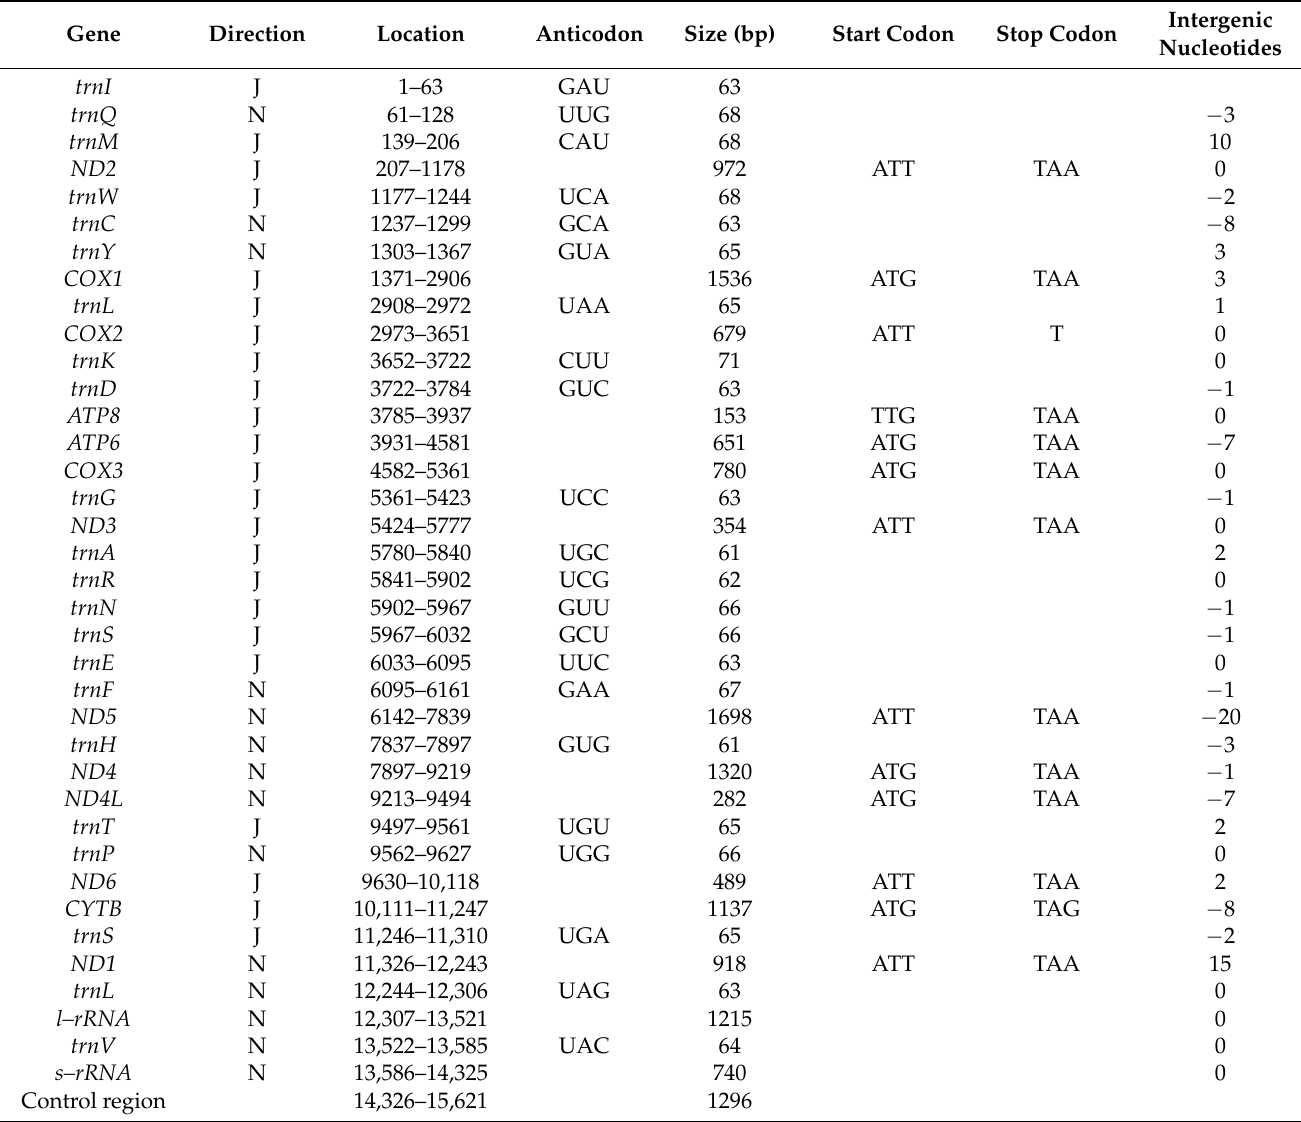
Table 2. Annotations for the Atkinsoniella grahami mitochondrial genomes.